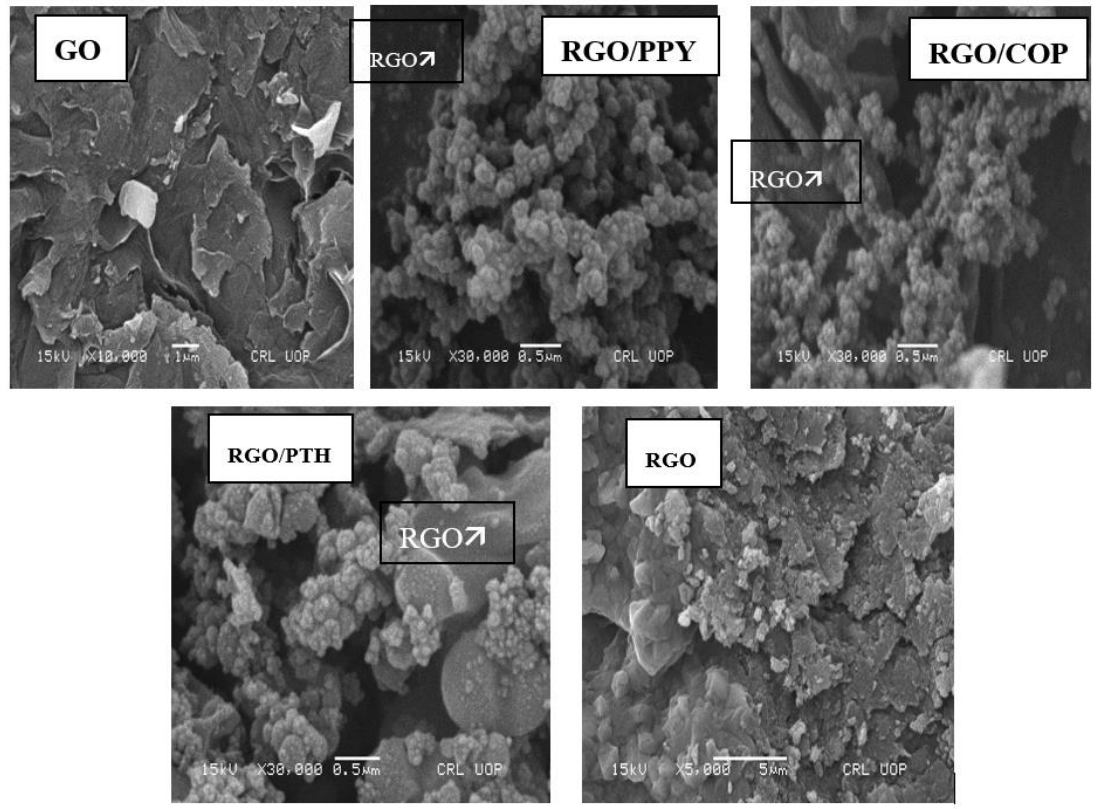
Figure 4. Scanning electron microscopy (SEM) images COP, PPY, PTH, RGO, RGO/PPY, RGO/PTH, and RGO/COP.